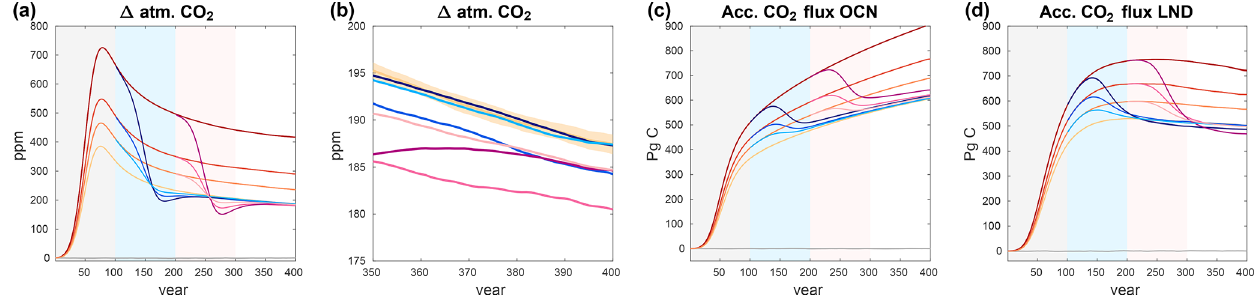
Figure 3. Atmospheric CO 2 concentration (a, b) and accumulated air–sea (c) and air–land (d) carbon fluxes in the B and overshoot sim- ulations. The colour code for the simulations is given in Fig. 1. The shading around the ensemble means indicates an estimate of internal variability as described in the text. An 11-year moving average filter has been applied to all time series. The shaded areas in the background indicate the different phases of the simulations (grey: positive emissions; light blue: negative emissions for the short overshoots; light red: negative emissions for the long overshoots).